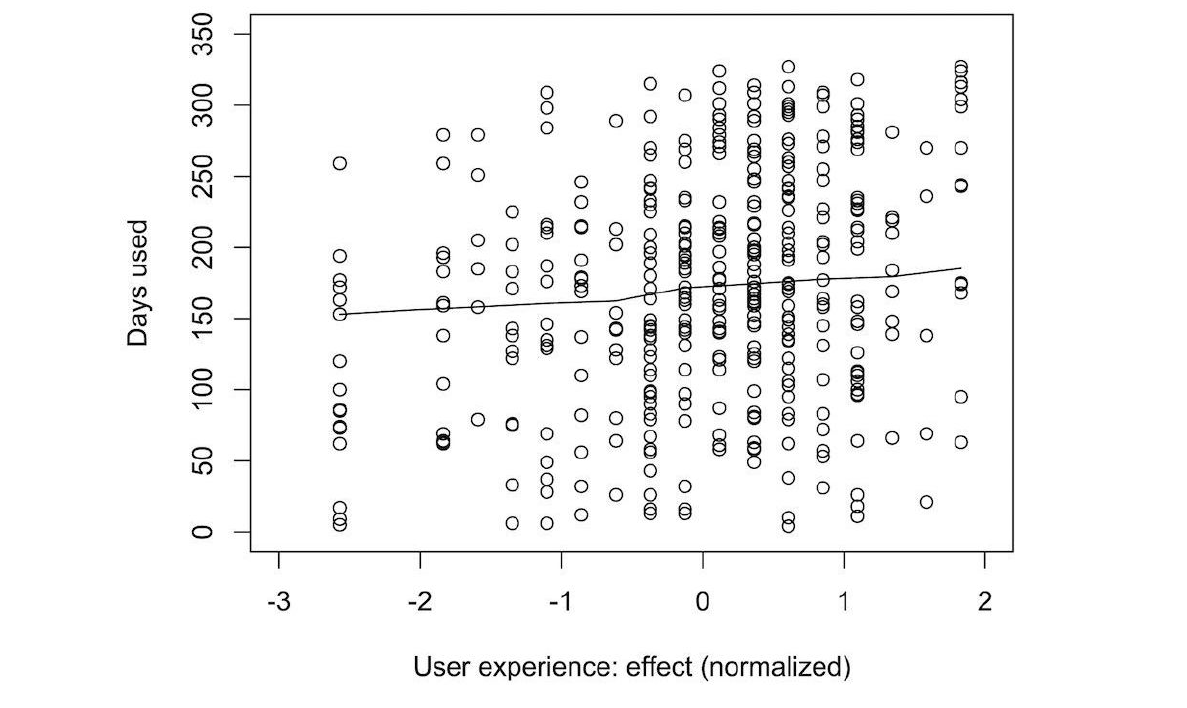
Figure 15. Plot of the partial dependence of sustained tracker use on user experience of the efficacy of the tracker. A better user experience leads to longer sustained